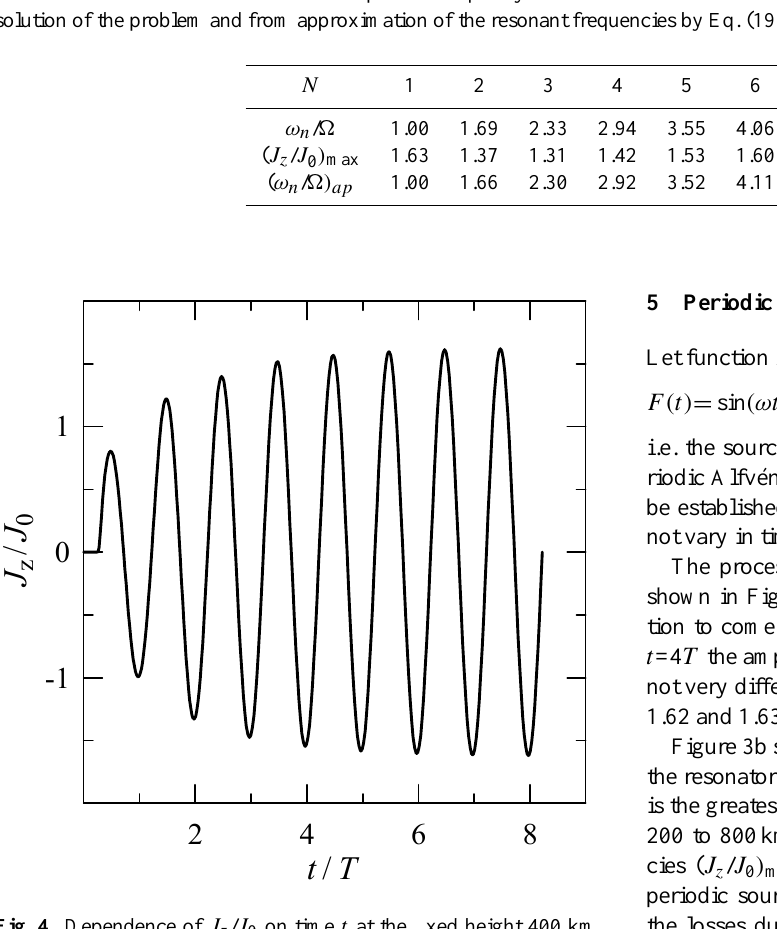
Fig. 4 to the paper by V.V. Alpatov et al. "Dynamics of Alfven waves ..." Table 1. Parameters of maxima at the amplitude-frequency characteristic of the resonator for a periodic source obtained from the numerical solution of the problem and from approximation of the resonant frequencies by Eq. (19) ( ω n / (cid:127)) ap .